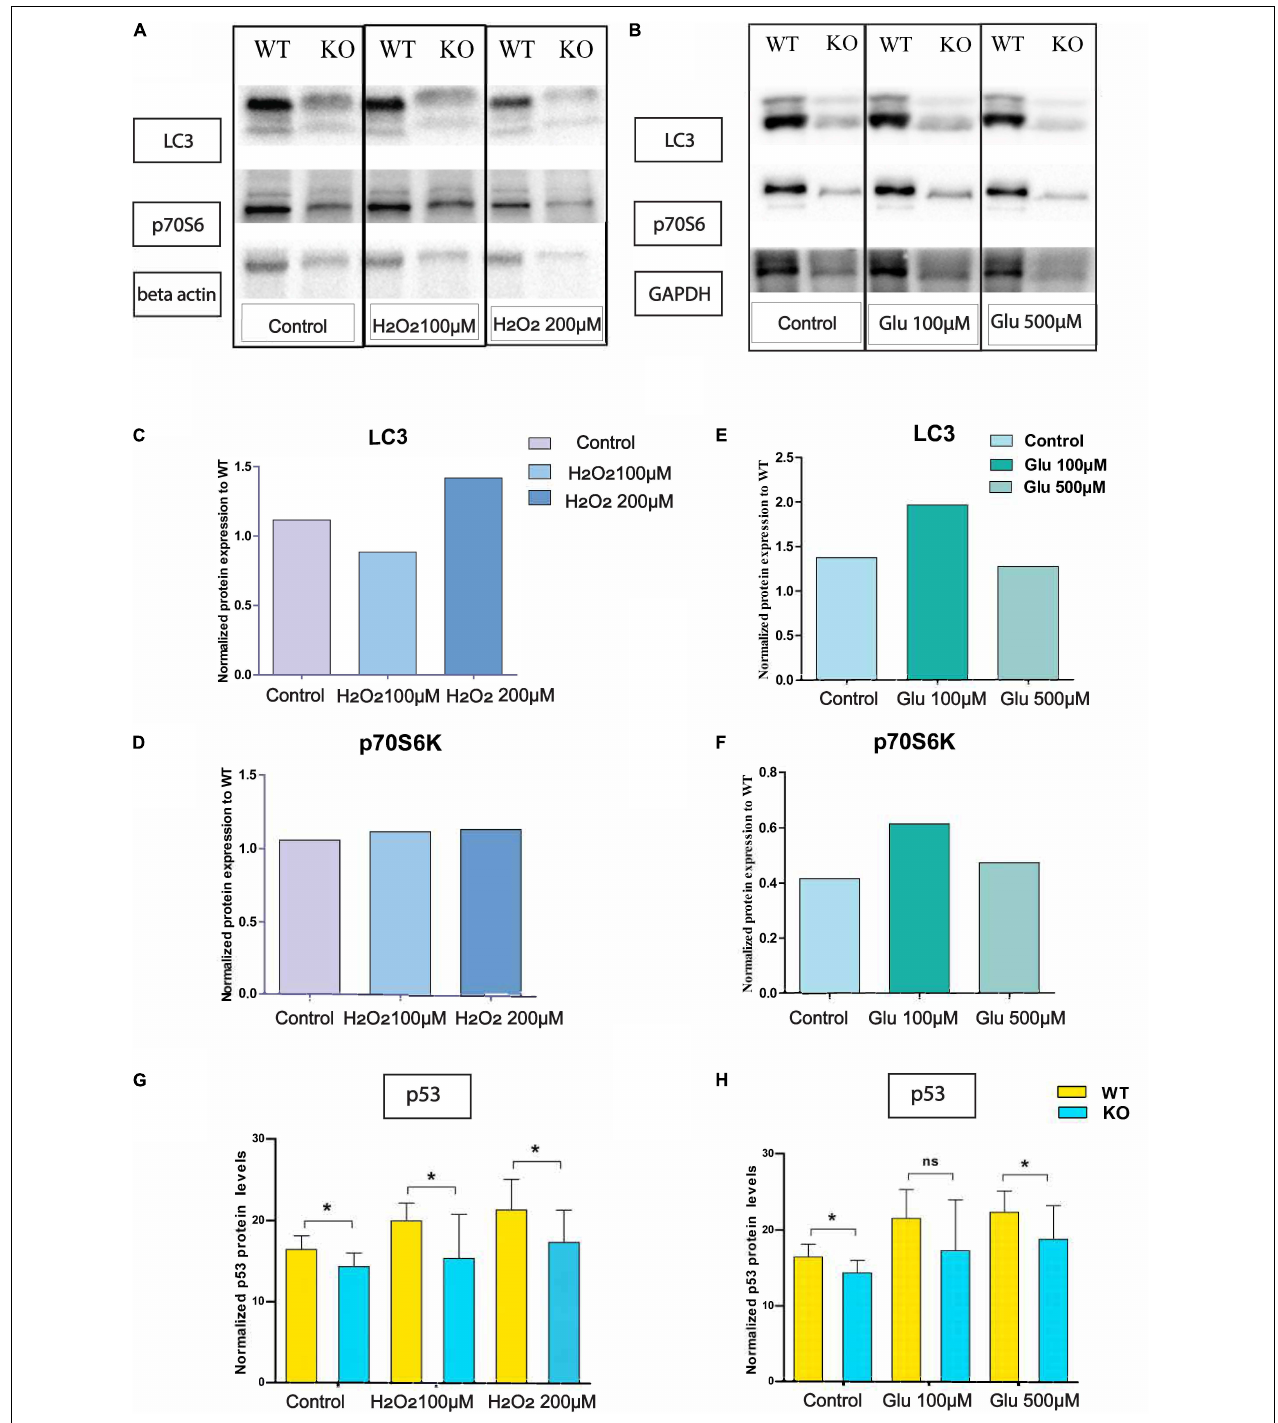
FIGURE 4 | Altered protein levels of protein expression in primary cortex cells of WT and KO under stress. Immunoblot data of antibody LC3 and p-70S6 on hydrogen peroxide (A) treated primary cortex cells from WT and KO. The graph represents the ratio of protein expression of LC3 (C) and p70S6 (D) in KO primary cortex cells compared to WT cells after normalization with respect to loading controls (beta-actin). Immunoblot data of antibody LC3 and p-70S6 under glutamate treated primary cortex cells from WT and KO (B) . The graph represents the ratio of protein expression of LC3 (E) and p70S6 (F) in KO primary cortex cells compared to WT cells after normalization with respect to loading controls (GAPDH). Intracellular p53 protein expression was measured using an In-Cell ELISA p53 kit. The graph represents means with SD, and an unpaired t -test was performed to compare KO and WT for cells exposed to oxidative stress (G) and glutamate excitotoxicity (H) with significance levels (* ≤